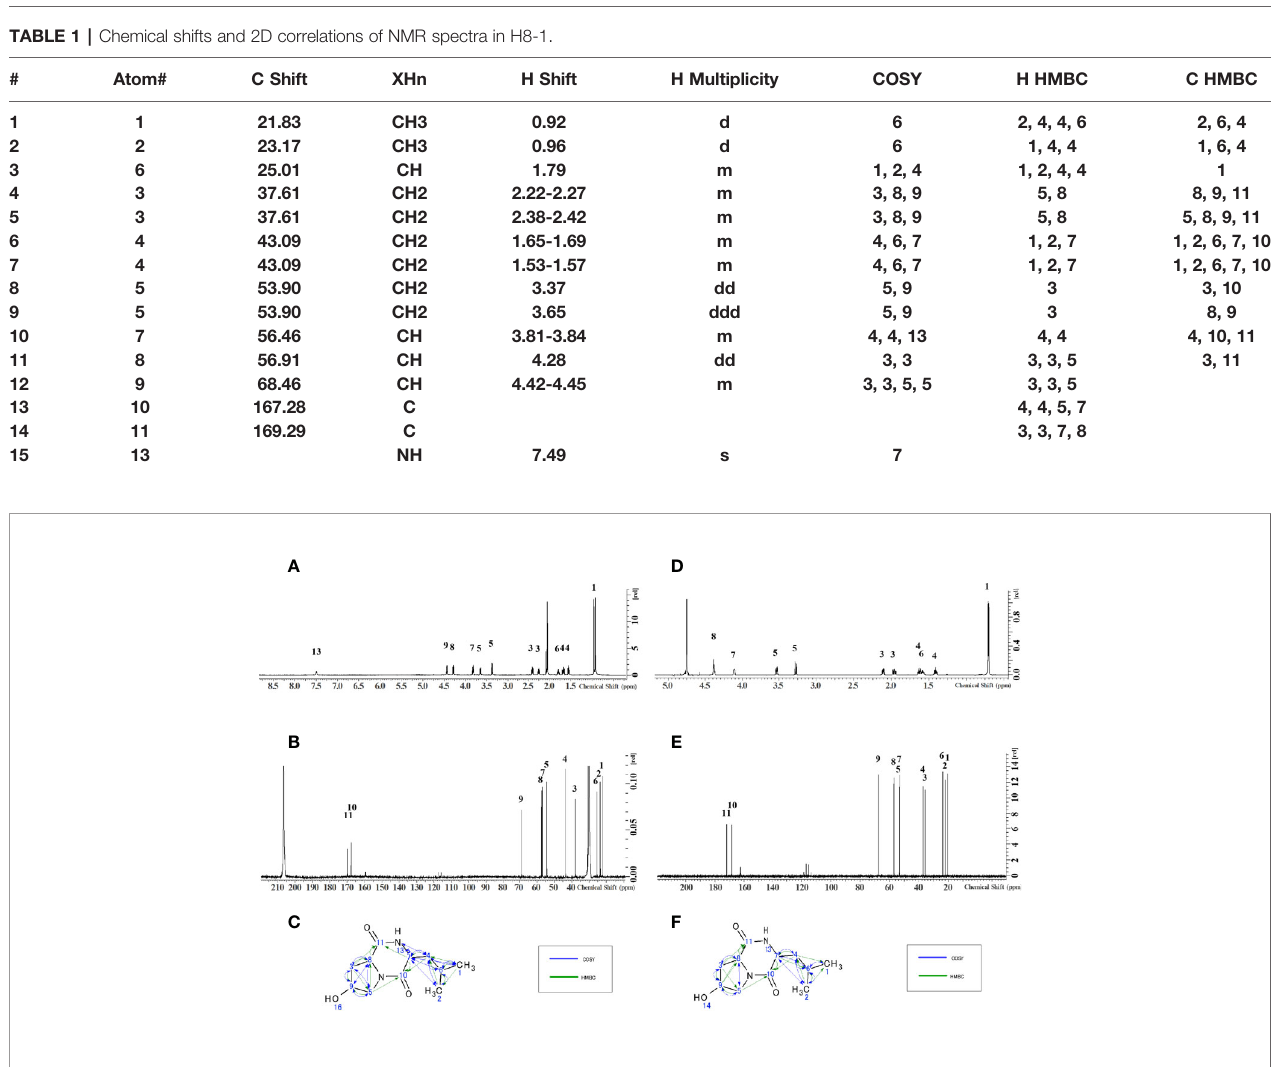
FIGURE 2 | Structure determination by NMR. (A) 1 H-NMR of H8-1, (B) 13 C-NMR of H8-1, (C) COSY and HMBC correlations of H8-1, (D) 1 H-NMR of H8-2, (E) 13 C- NMR of H8-2, (F) COSY and HMBC correlations of H8-2.